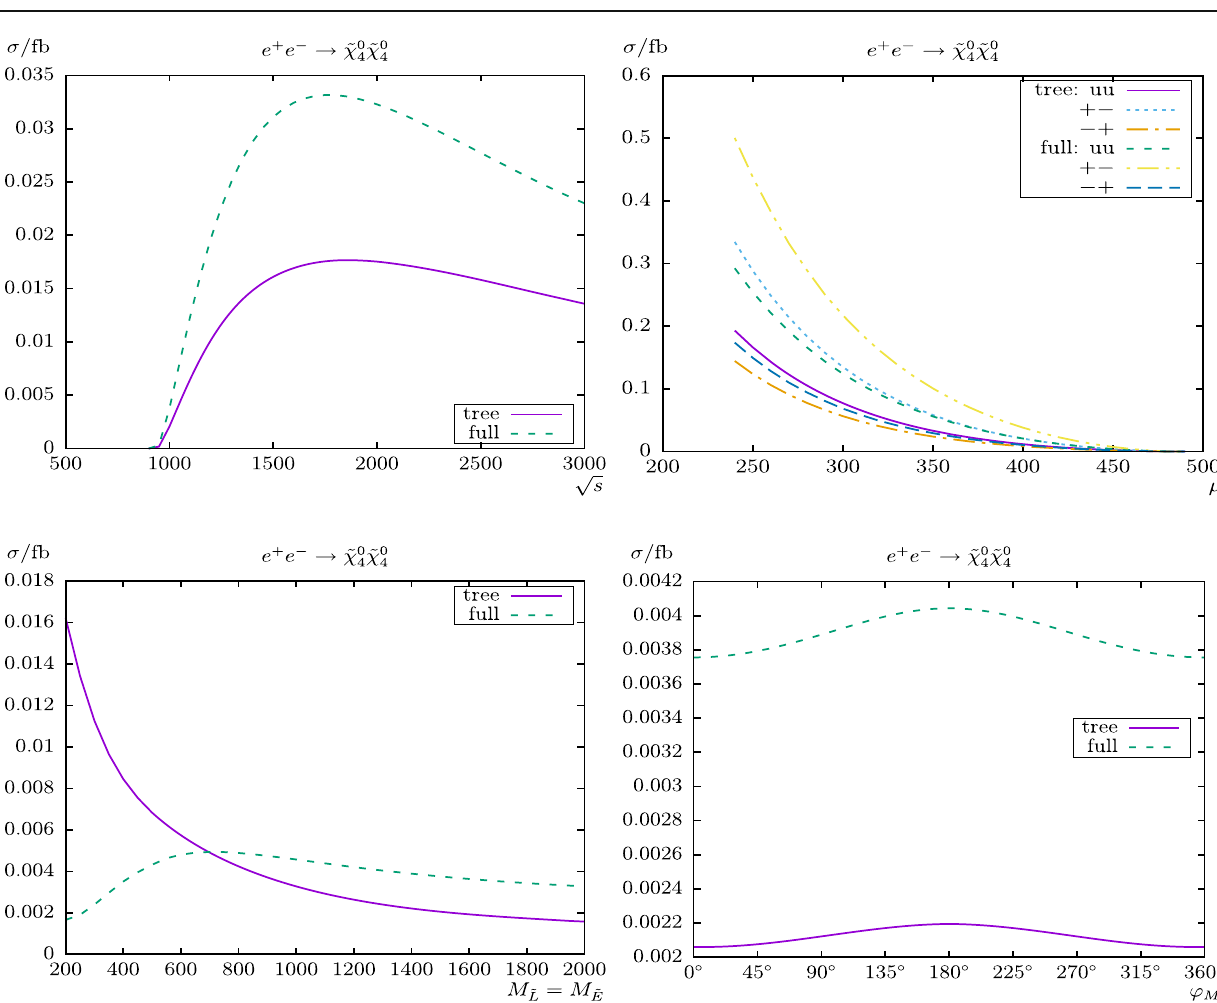
= M ˜ (left) and ϕ M (right) L E 1